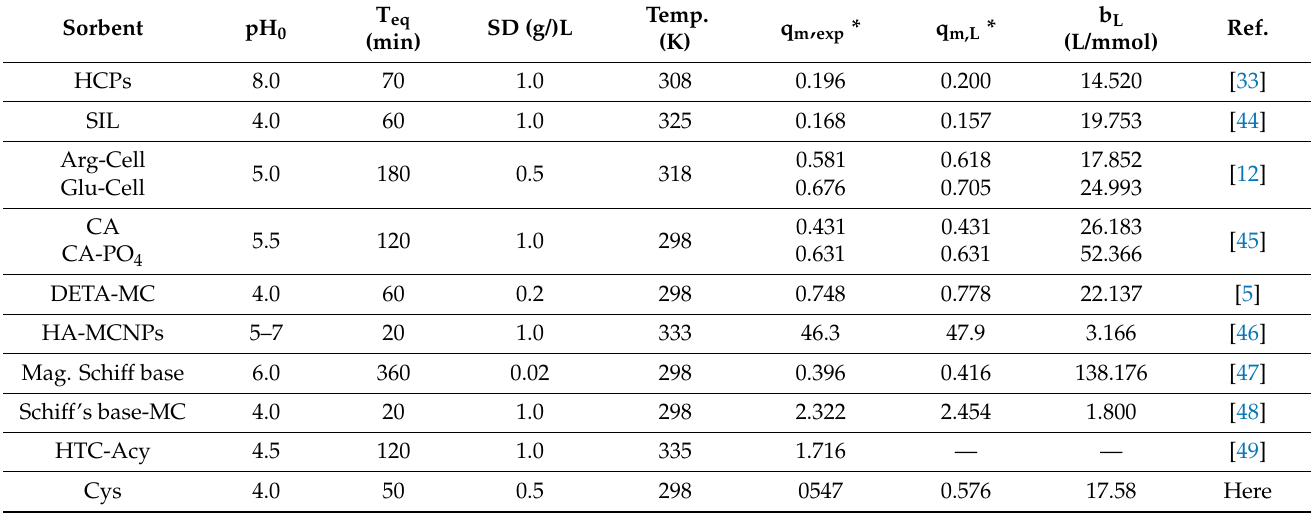
Table 5. Uranium sorption performances using different